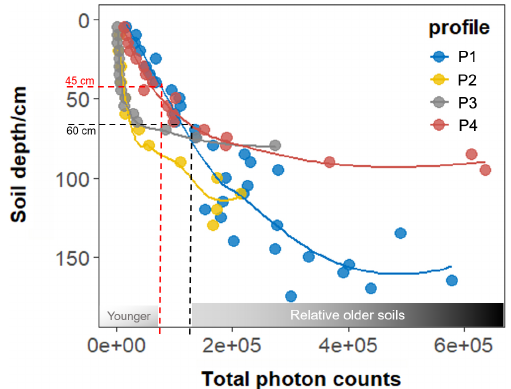
Figure 2. The total photon counts versus soil depth in terrace soils. The two soil burial-age categories are shown with dashed lines (i.e., above 45cm = young, below 60cm =